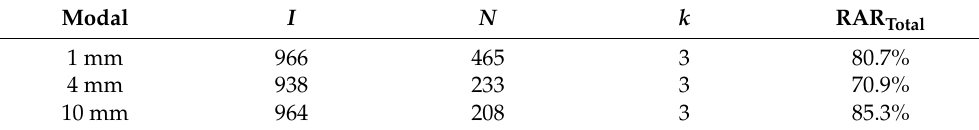
Table 2. Modeling discrimination effects of the optimal MW-kNN models of three measurement modals. Modal I N k RAR